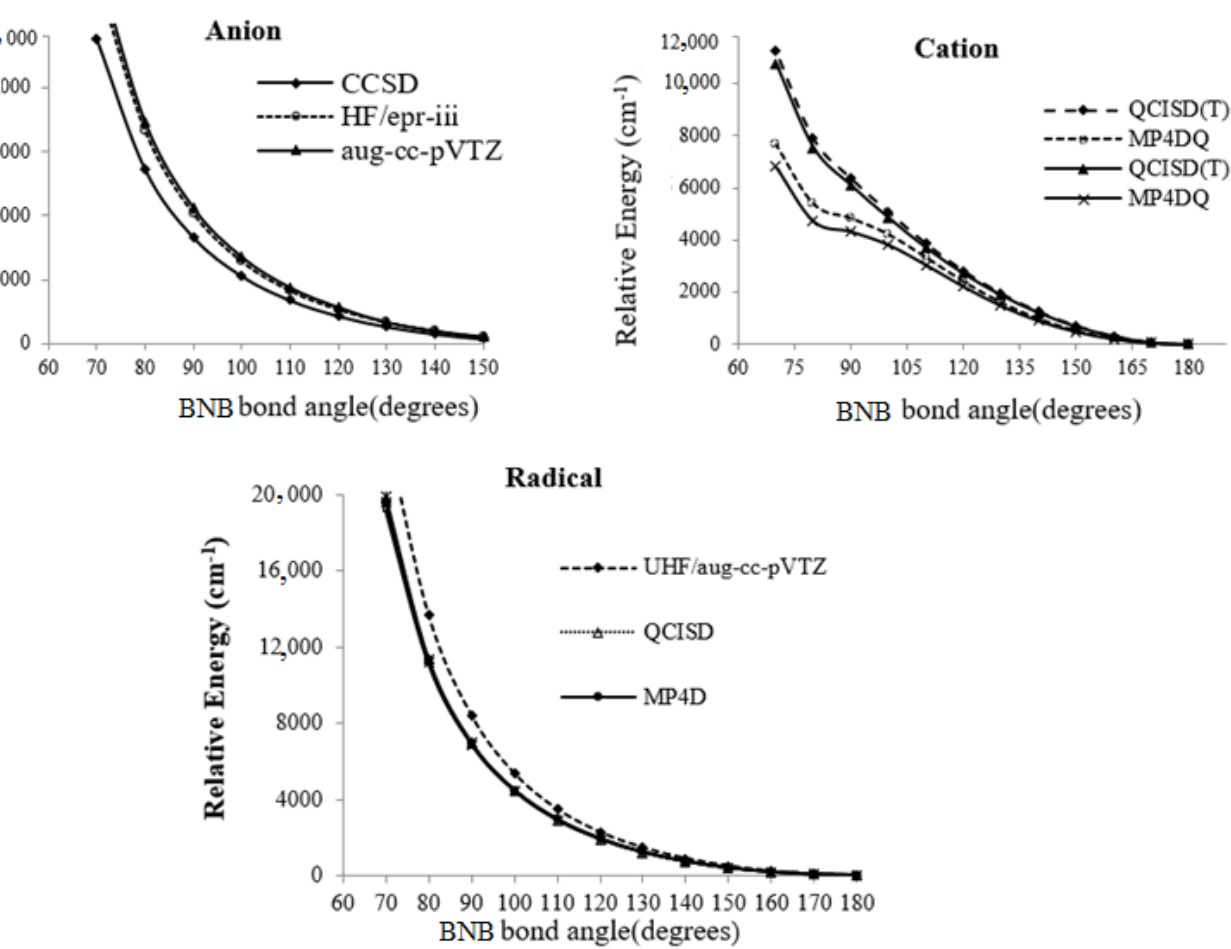
( − ,0, +) versus B-N-B bond angle at various levels of the Figure 2. Relative energies of B 2 𝑁 (−,0,+) versus B-N-B bond angle at various levels of the theory. Figure 2. Relative energies of B 2 N